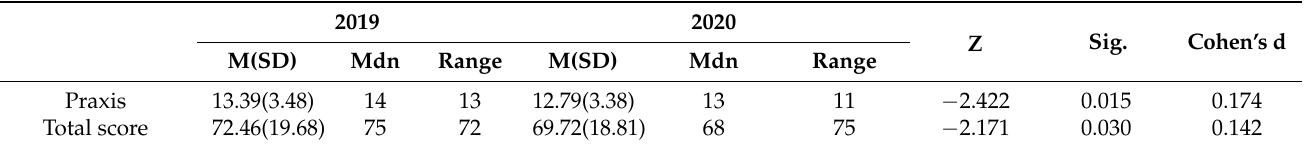
Table 5. Comparison 2019–2020. Age group up to 45 inclusive ( n = 45). Wilcoxon Z Range test for related samples.